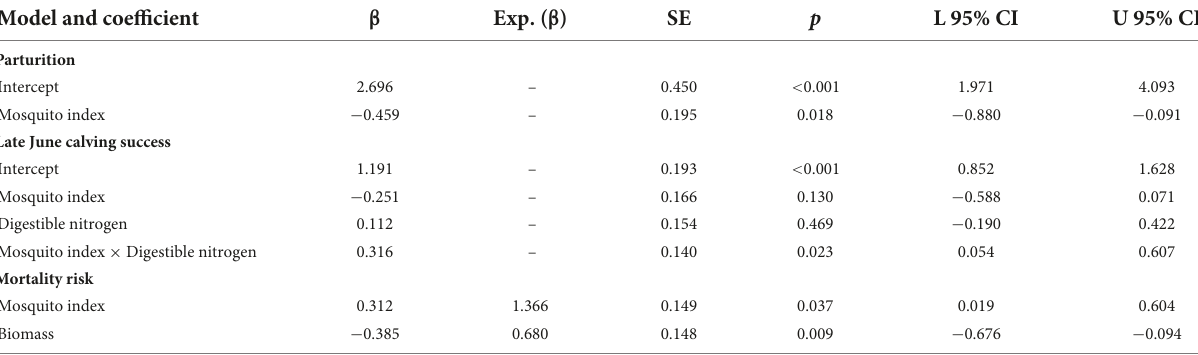
TABLE 2 Standardized coefficients from the top individual-level models of parturition, late June calving success, and hazards to 9-month survival (September–May) for adult female caribou in the Central Arctic Herd, Alaska, 2003–2020. Model and coefficient β Exp. ( β )